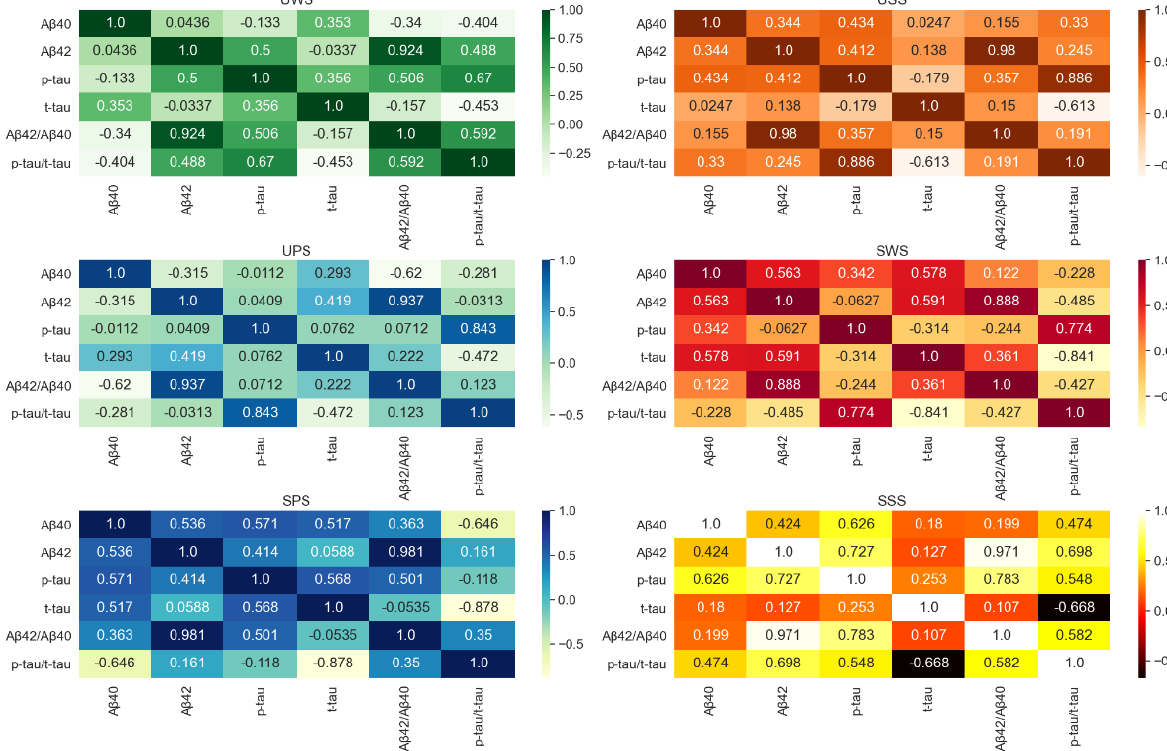
Figure 2. The correlation between different saliva biomarkers.